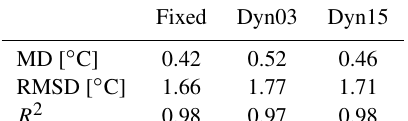
Table 4. Mean deviation, root-mean-square deviation, and coeffi- cient of determination, for the modelled and observed 10m temper- ature.